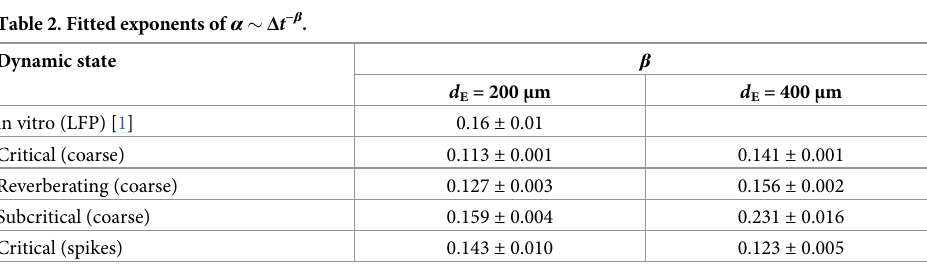
Table 2. Fitted exponents of α � Δ t − β